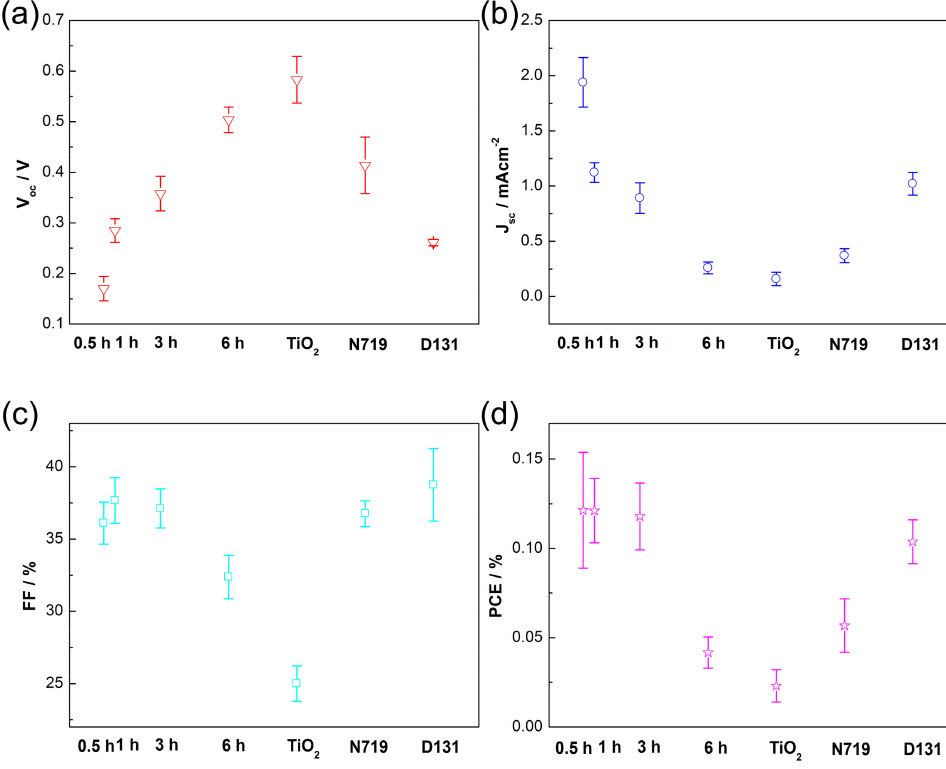
Figure 6. Detailed PV parameters of ( a ) V oc ; ( b ) J sc ; ( c ) FF; and ( d ) PCE as a function of the C60 absorption durations and types of